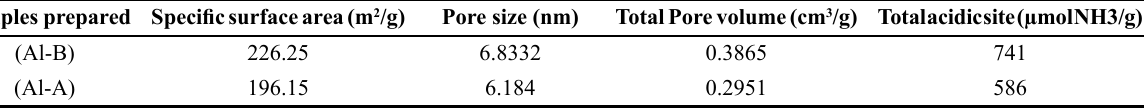
Table.1 . BET and NH3-TPD data for catalysts samples